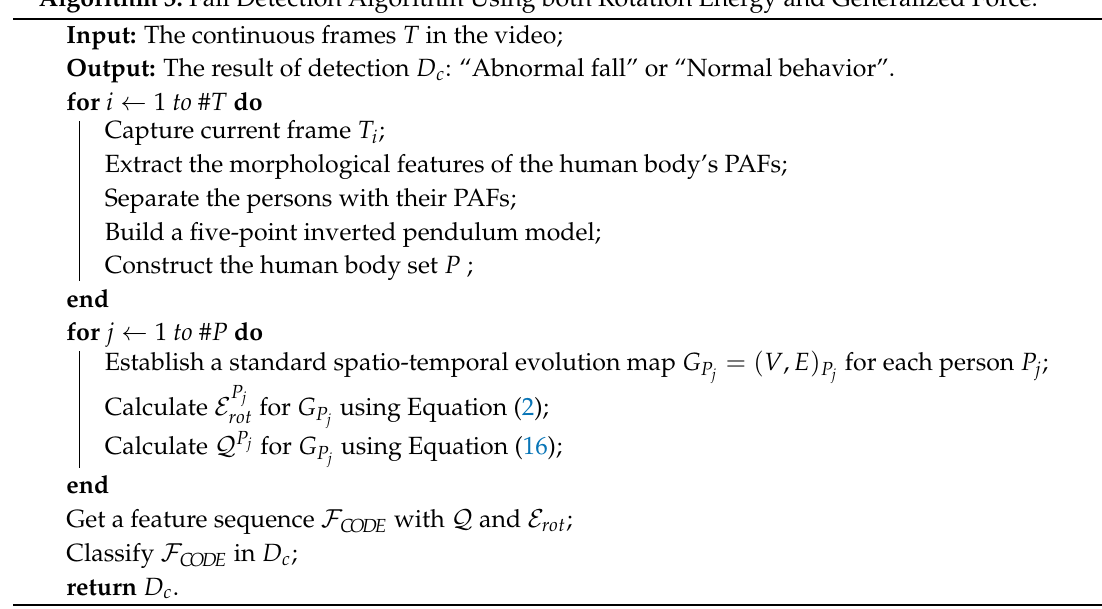
Algorithm 3: Fall Detection Algorithm Using both Rotation Energy and Generalized Force.